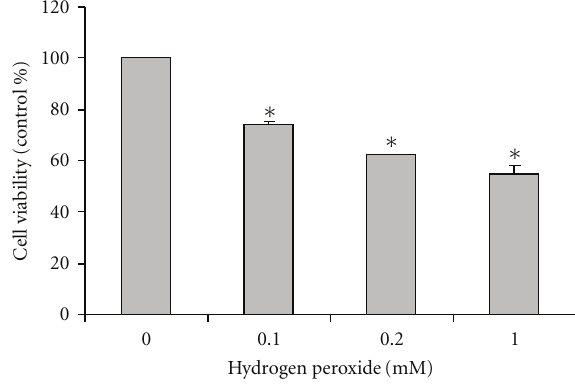
Figure 1: E ff ect of H 2 O 2 -induced reduction in cell viability in SH- SY5Y cultured cells. SH-SY5Y cells were treated with H 2 O 2 at 0.1, 0.2, and 1.0mM for 24 hours. Cell viability was assessed using MTT assay and presented as percentage of untreated (0mM) control cells. The results are expressed as mean ± SEM of four independent experiments. The ANOVA was performed for statistical analysis ( ∗ P < . 05 compared with control).